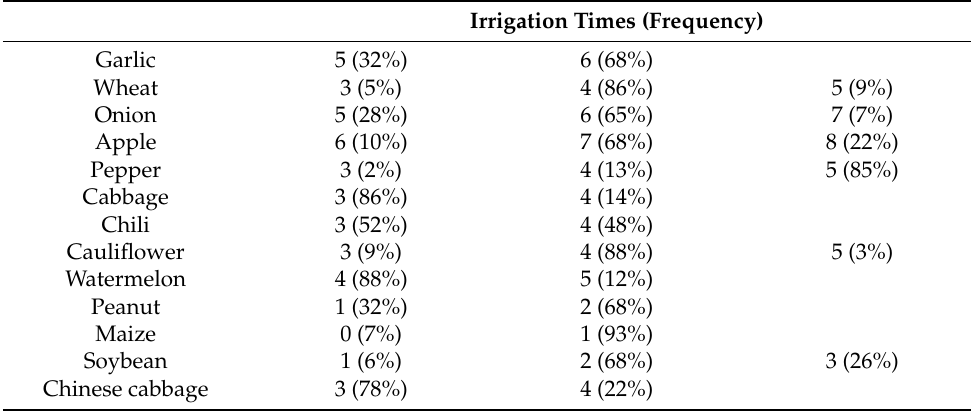
Figure 2. Irrigation water use of different crops (bars represent the standard deviations for different farmers). Table 2. Irrigation times and frequencies of different crops.